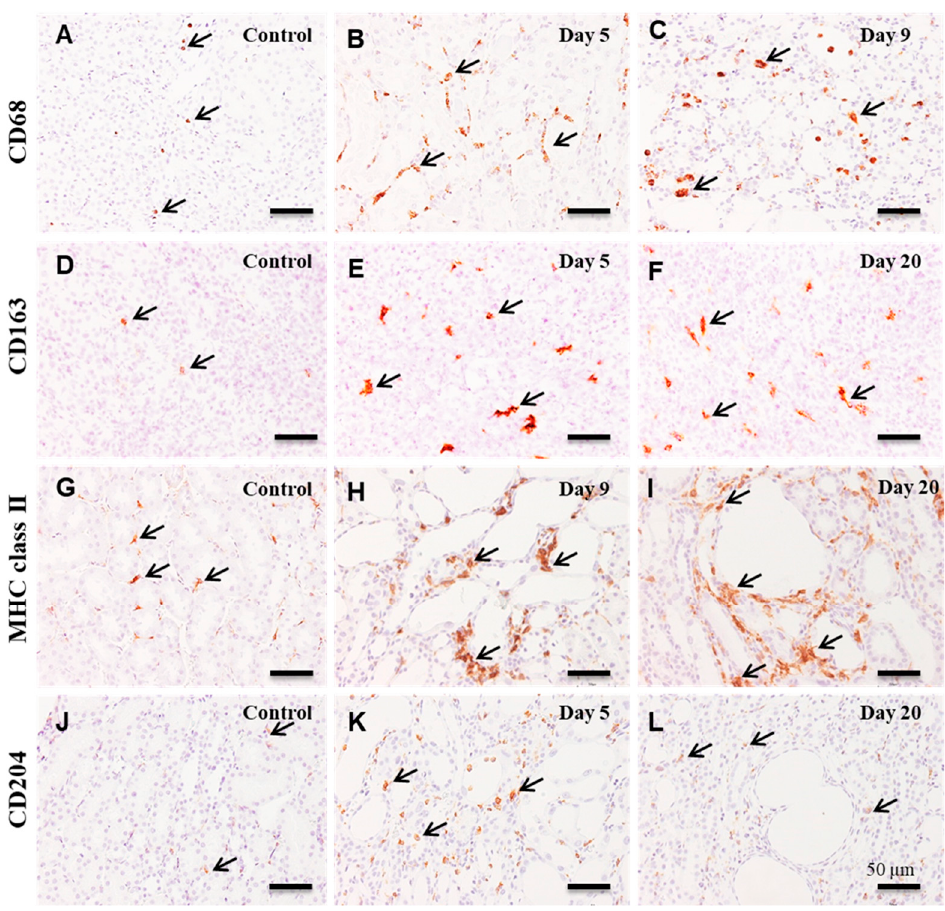
Figure 5. Immunohistochemistry for CD68 ( A – C ), CD163 ( D – F ), MHC class II ( G – I ), and CD204 ( J – L ) in the control and CDDP-treated kidneys. A few CD68 + macrophages (arrows) are seen in the corticomedullary junction of control kidneys ( A ), whereas many macrophages reacting CD68 (arrows) are present around the affected renal tubules on days 5 ( B ) and 9 ( C ). In contrast to control ( D ), many CD163 + macrophages (arrows) are seen on days 5 ( E ) and 20 ( F ). Increased numbers of MHC class II + macrophages (arrows) are seen exclusively around the affected renal tubules on days 9 ( H ) and 20 ( I ), in contrast to control ( G ). Only a few CD204 + macrophages are present in the control ( J ) and on day 20 ( L ), whereas, on day 5, CD204 + macrophages are increased ( K ). Note that there are differences in the distribution and location of these macrophages from each other. Counterstained with hematoxylin. Bar = 50 µm.